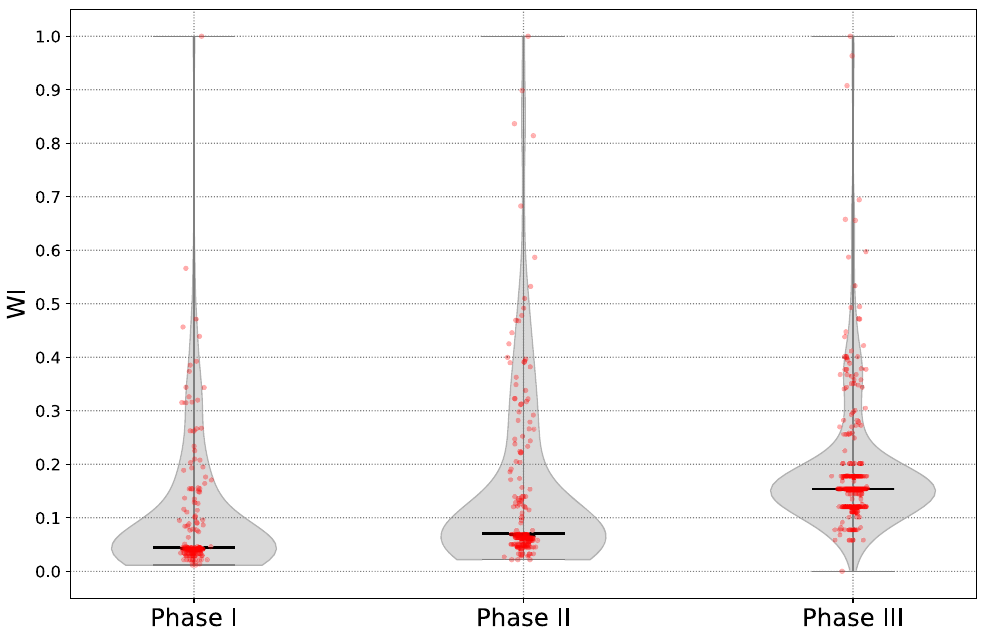
Figure 10: Comparison of the WI distribution of Dunaújváros Phases I to III ( c. 2200 – 1450 BCE ) . Bold black bars indicate the